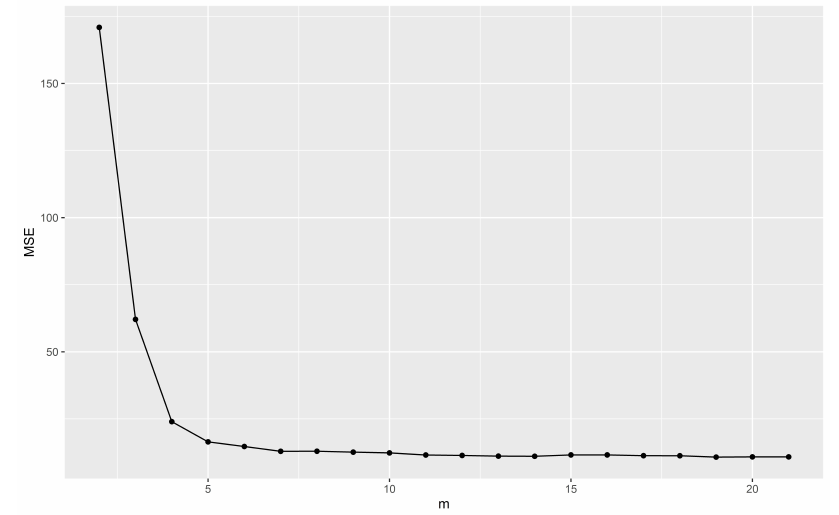
Figure 3. Mean square error for risk score fitted values when adjusting m